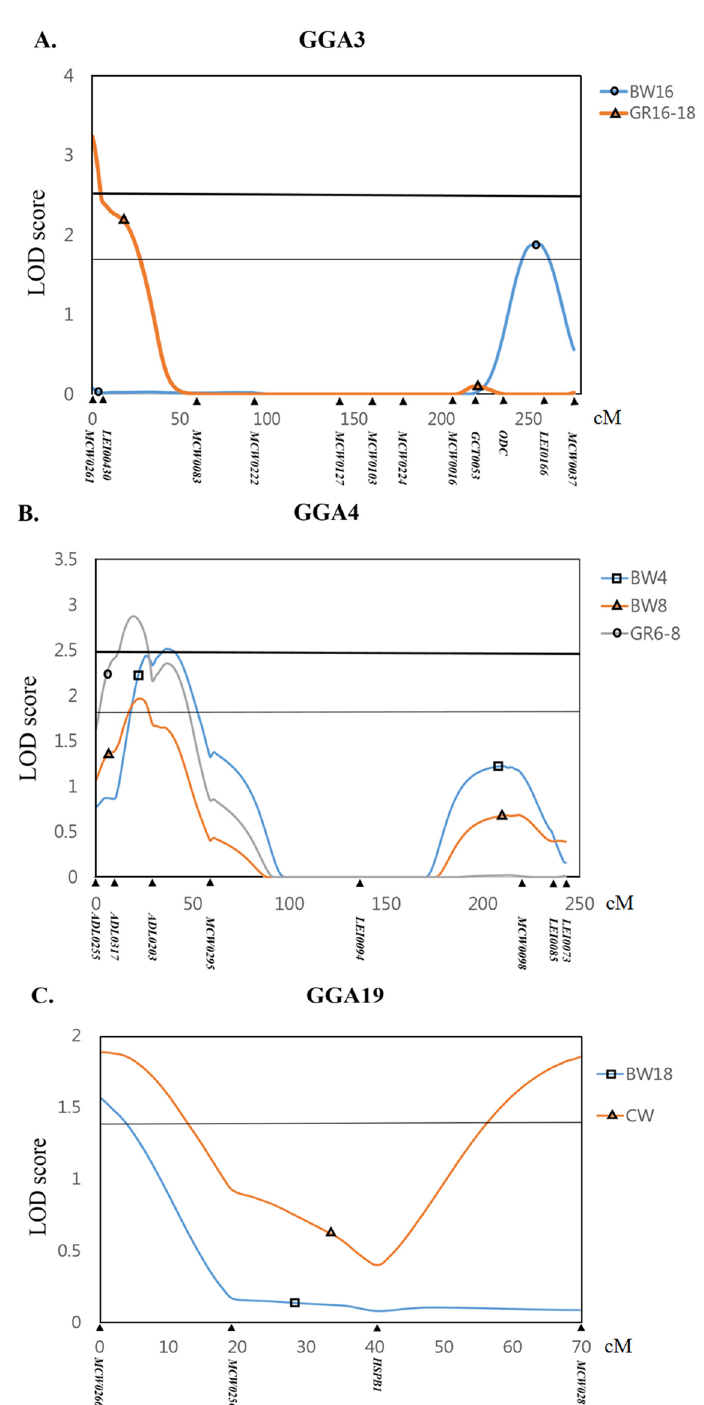
Figure 1. Test statistic profiles for body weight and growth traits on GGA3 (A), GGA4 (B), and QTL for body weight (BW) 18 and (carcass weight) CW on GGA19 (C). The y-axis represents the LOD score testing the hypothesis of a QTL in a given genomic position. Marker map with distances between markers in Kosambi centi Morgan (cM) is given on the x-axis. Colored lines represent QTL profiles for each trait. The horizontal thick and thin black lines represent the 1% and 5% chromosome-wide significant thresholds, respectively. GGA, chicken chromosome; QTL, quantitative trait loci; LOD, logarithm of the odds; cM, centi